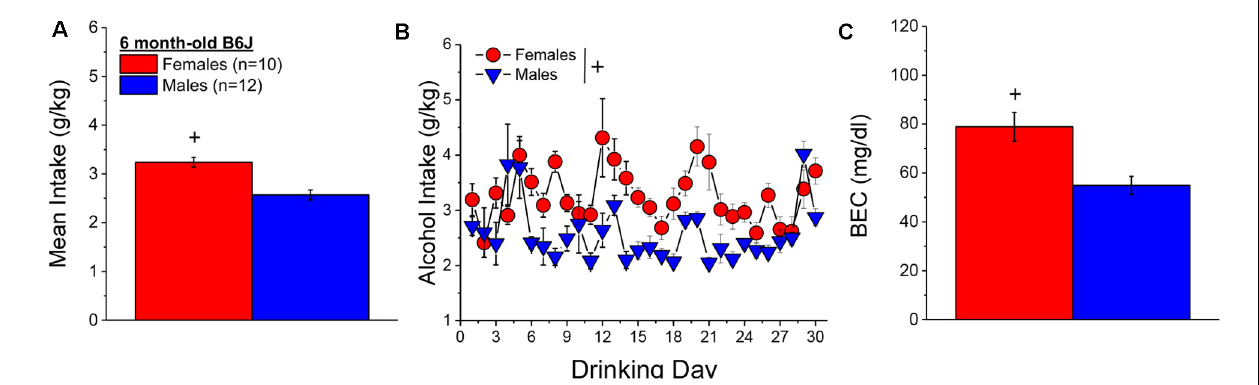
FIGURE 5 | Binge drinking during later maturity (6 months of age) in a cohort of isogenic C57BL/6J mice. (A) On average, females in Experiment 2 consumed more alcohol than males over the 30-day course of binge drinking. (B) Comparison of the time-courses of binge drinking between Experiment 2 male and female mice. (C) Consistent with the sex difference in binge drinking, BECs were higher in females vs. males in Experiment 2. The data represent the means ± SEMs of the number of mice indicated in parentheses in Panel (A) . + p < 0.05 Females vs. Males.